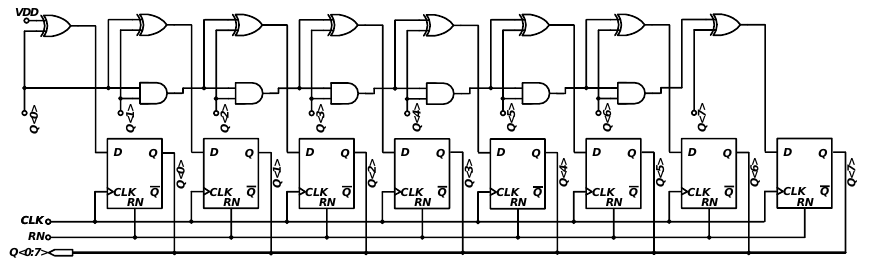
Figure 7. Eight-bit synchronous counter.